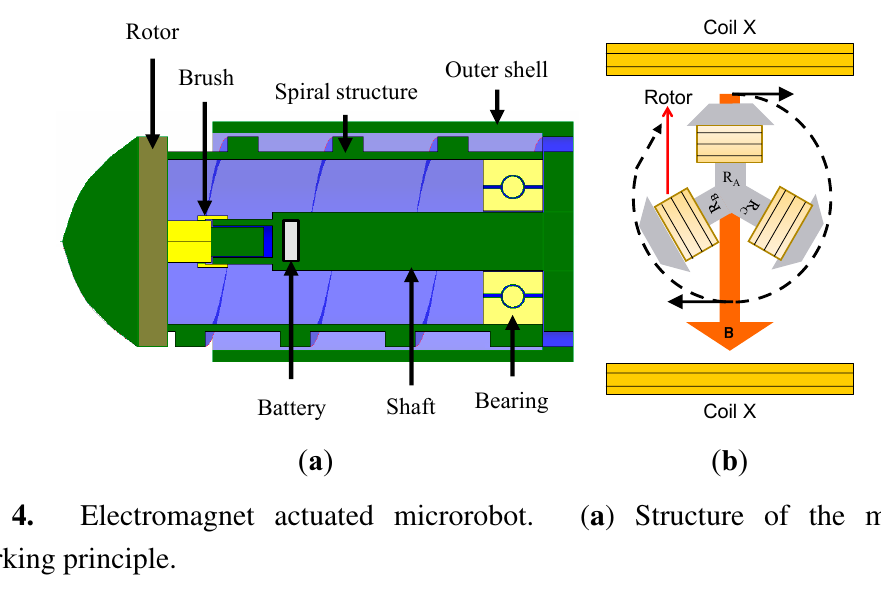
Figure 4. Electromagnet actuated microrobot. ( a ) Structure of the microrobot; ( b ) Working principle.